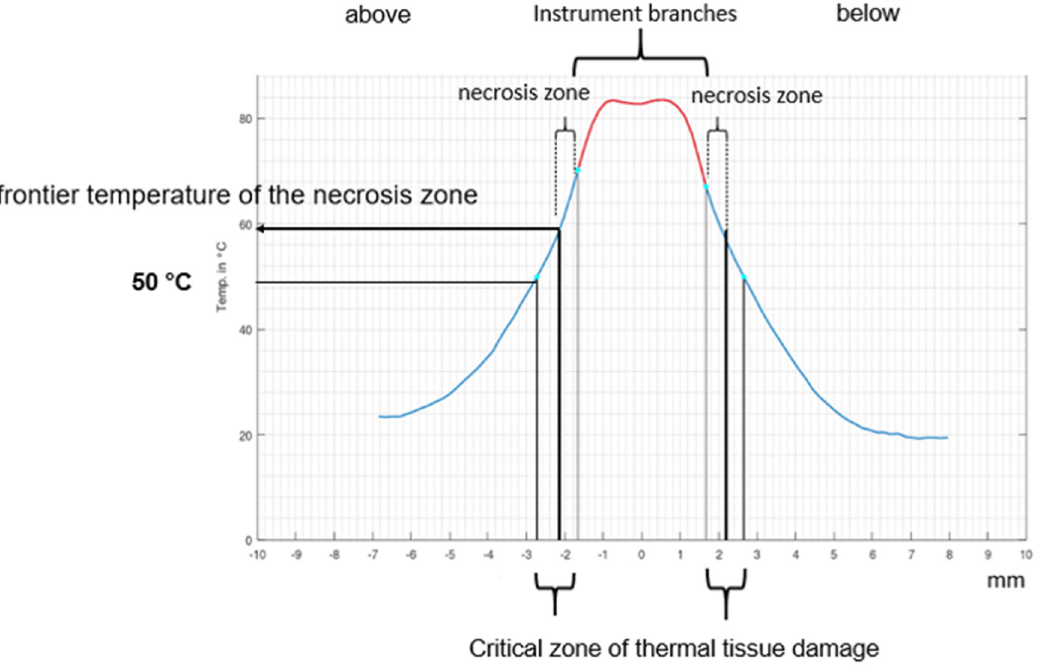
Figure 2. Example of a temperature curve, demonstrating the different zones for necrosis and potential thermal damage (print from the MATLAB program).